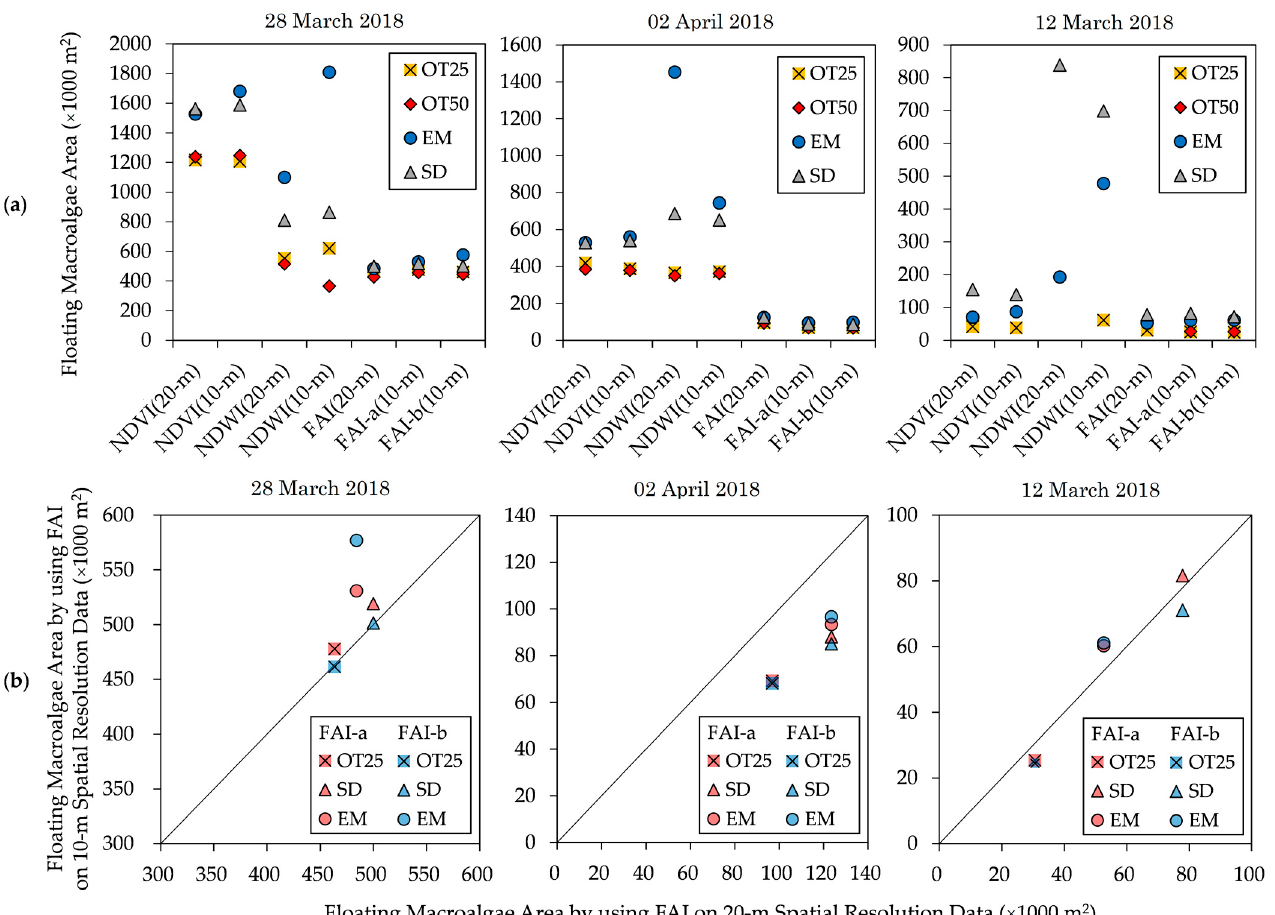
Figure 8. Estimated floating macroalgae area obtained by ( a ) various floating macroalgae detection indexes and by ( b ) FAI using Sentinel-2 satellite data with 10 m and 20 m spatial resolutions. NDVI, normalized difference vegetation index; NDWI, normalized difference water index; OT25, Otsu’s method based on 25% sub-area; OT50, Otsu’s method based on 50% sub-area; SD, standard deviation method; EM, exclusion method. The details of these methods are found in the main text.